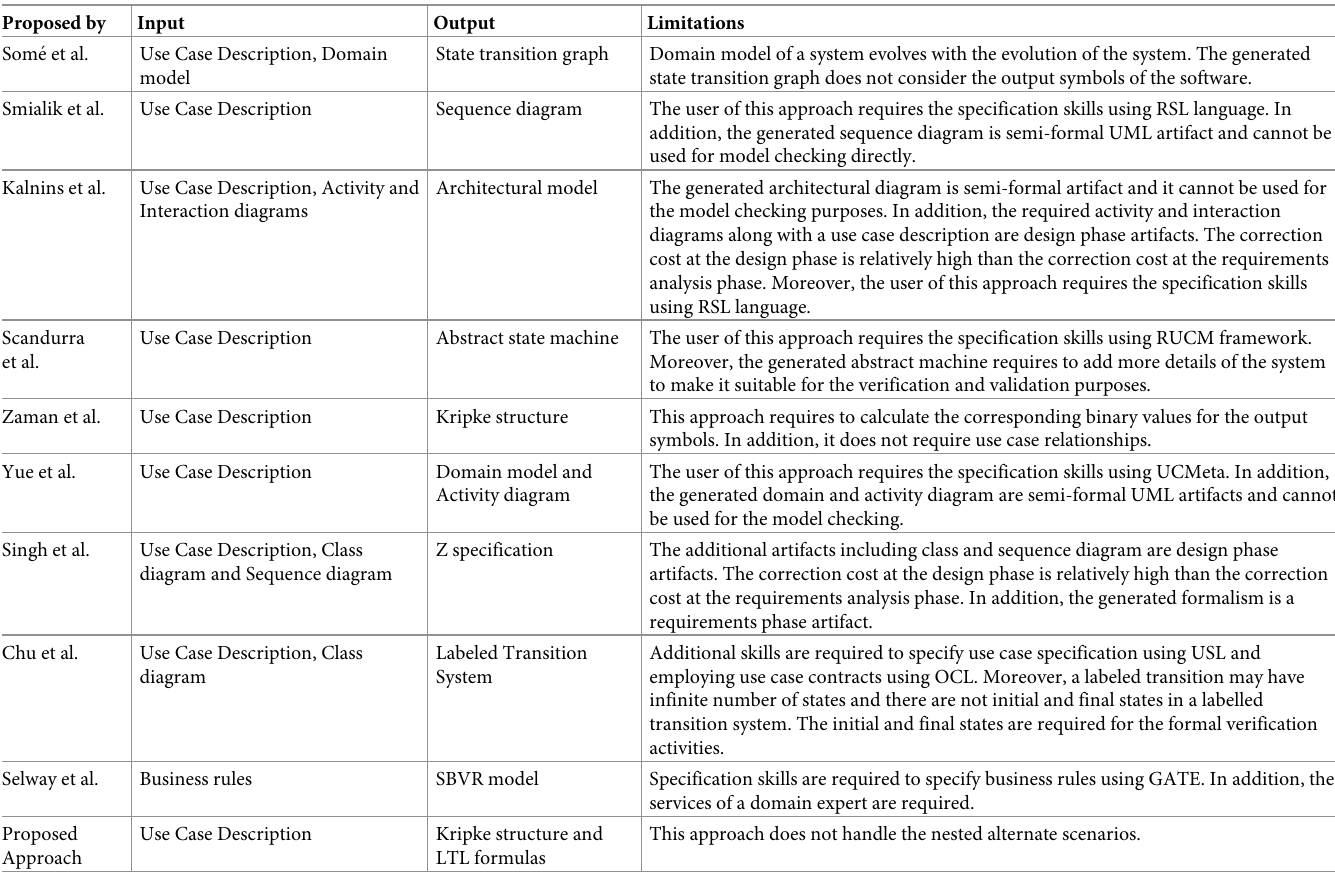
Table 2. Analysis of existing approaches with the proposed